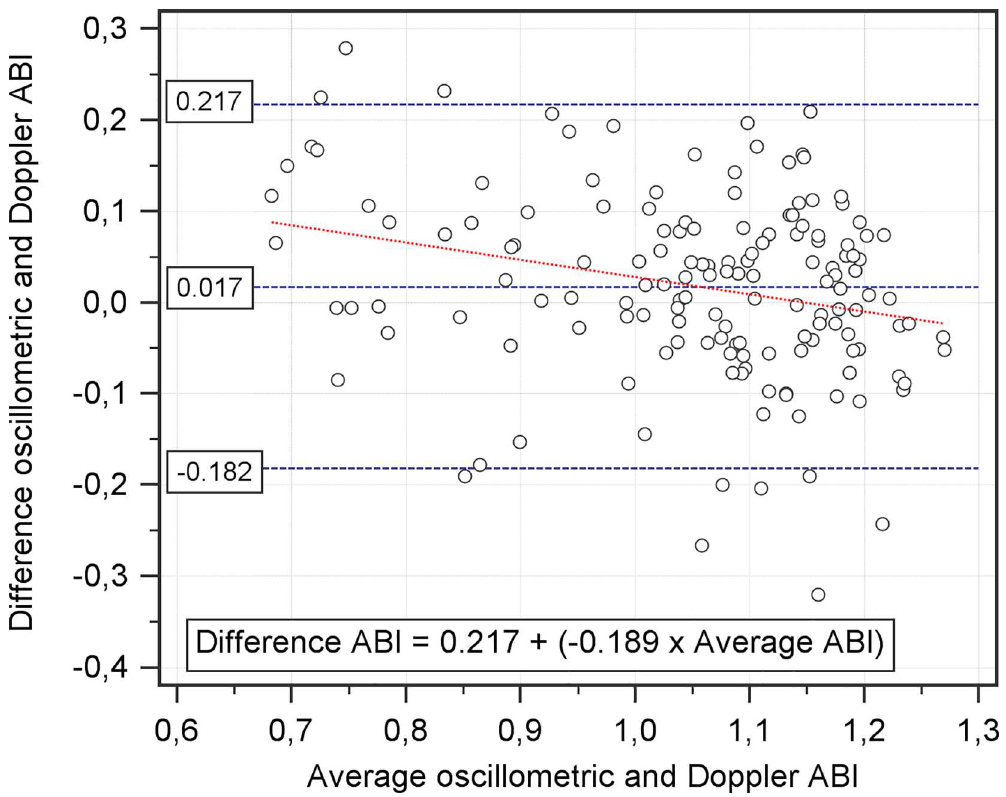
Fig 2. Bland and Altman plot of the oscillometric and Doppler ABI. The differences betweenboth methods, oscillometric and Doppler, are plotted as a function of the averageof the two methods (n = 151). The blue dashed lines show the mean difference with 95% CI. Red dashedline shows the linear